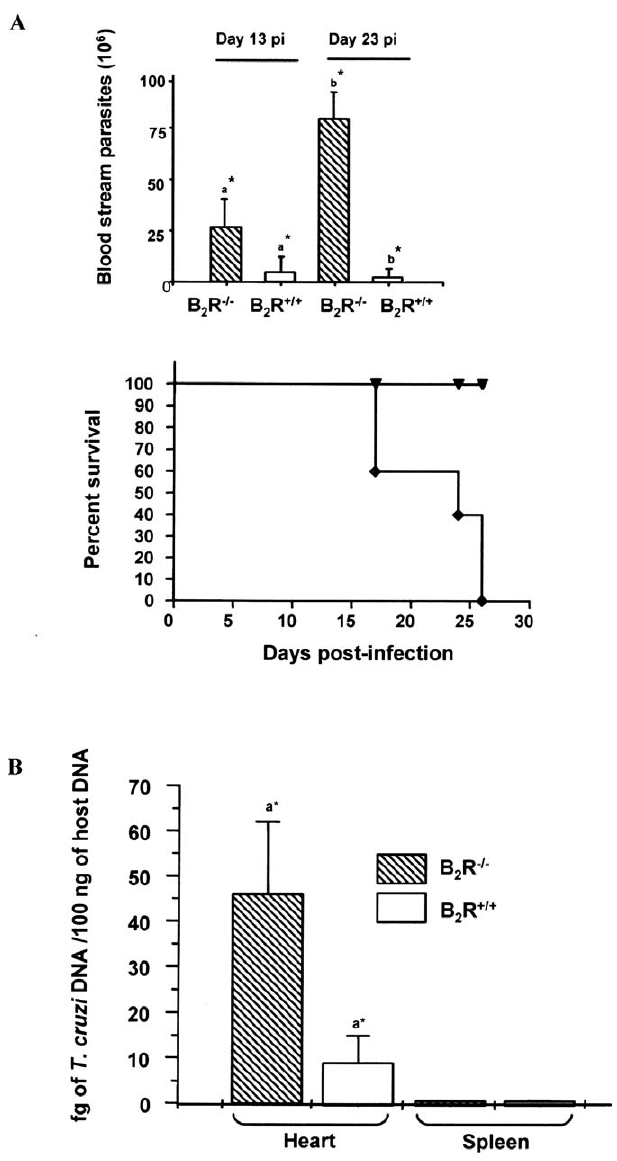
Figure 1. B 2 R (cid:2) / (cid:2) Mice Are Susceptible to T. cruzi Infection by the Intraperitoneal